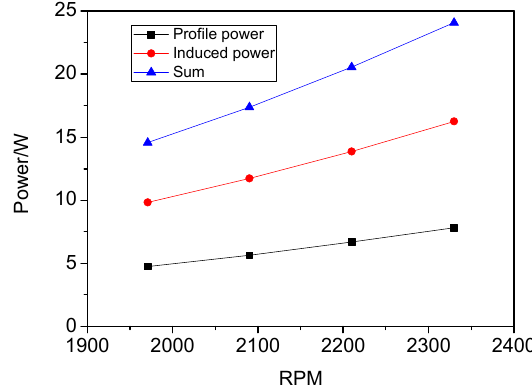
Figure 8. Power consumption.